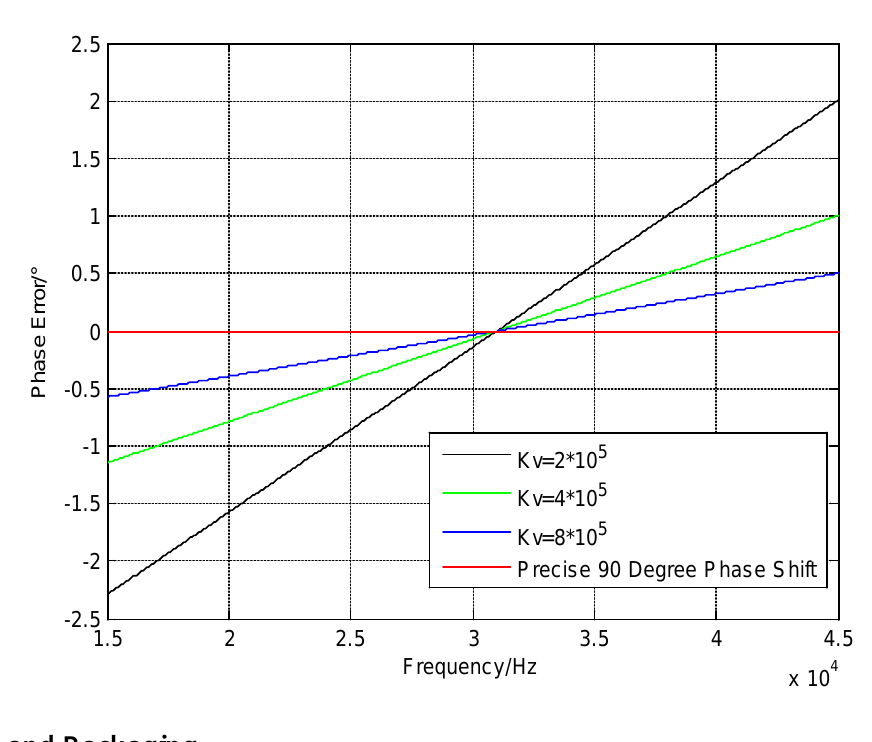
Figure 13 ． Curves of the variation of the steady-state phase